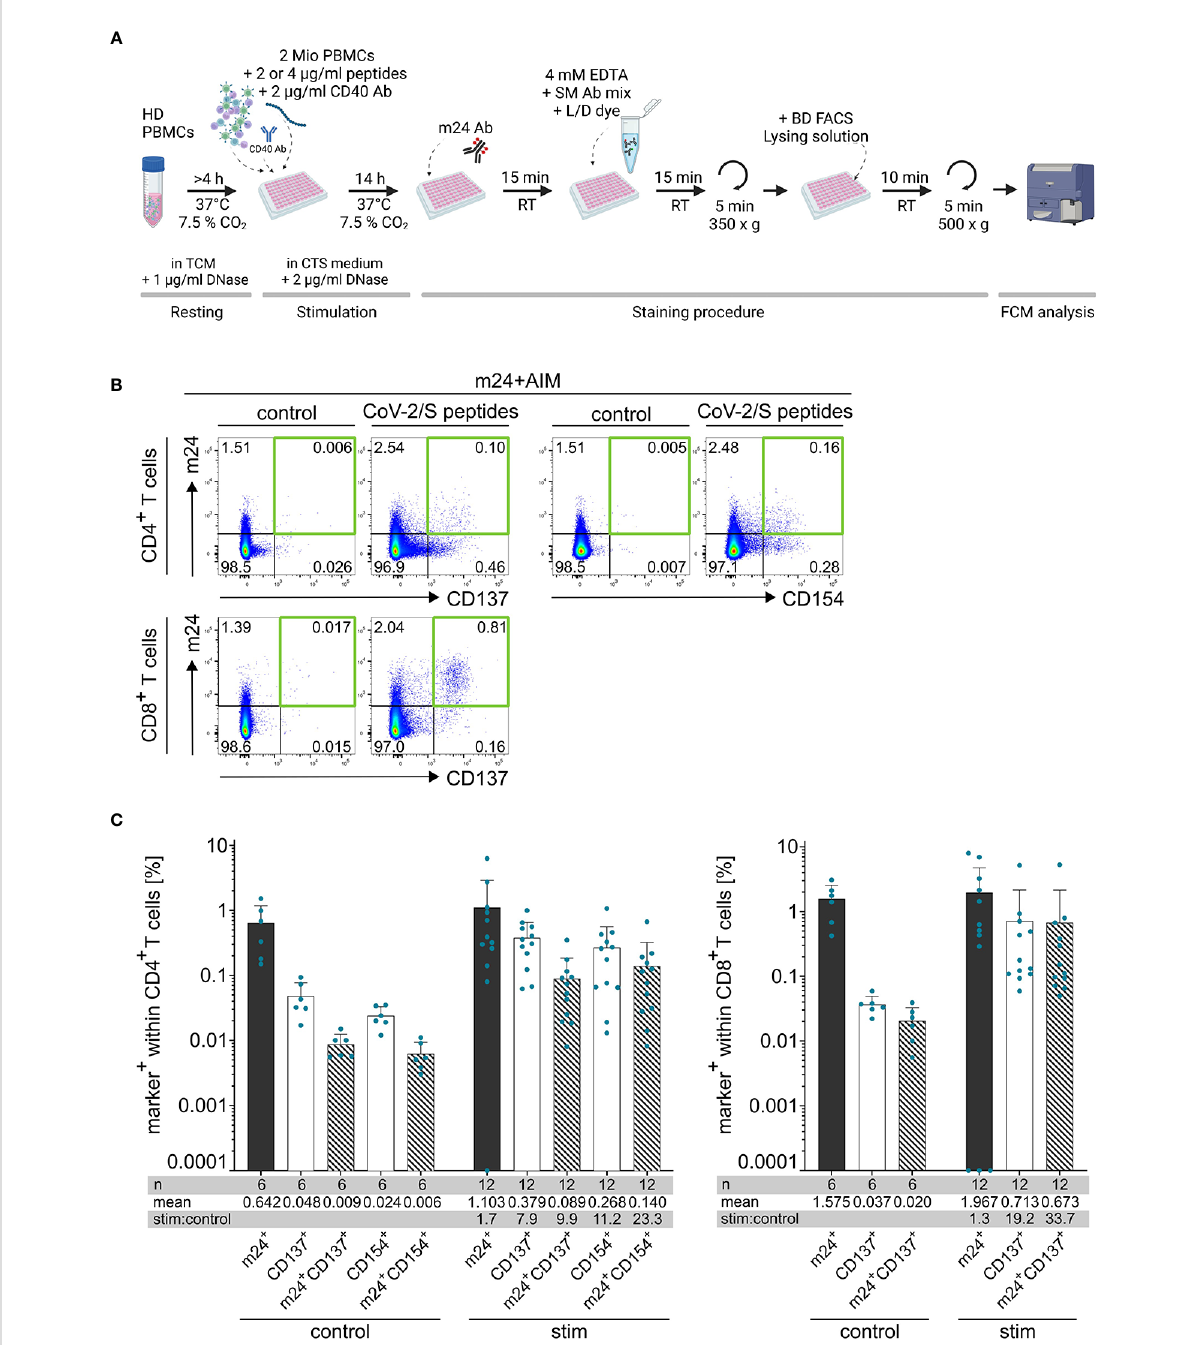
FIGURE 1 Co-staining of cell surface activated ß 2 -integrins with CD137 and CD154 (m24+AIM) allows identi fi cation of antigen-speci fi c T cells. (A) Scheme of the m24+AIM protocol (created with BioRender.com). PBMCs from healthy donors (HD) are stimulated with antigenic peptides or left unstimulated for 14 h in CTS medium + DNase in the presence of CD40 Ab. Activated ß 2 -integrins are then stained with m24 Ab, followed by incubation with EDTA, surface markers (SM) and live/dead dye (L/D) before fi xation and analysis by fl ow cytometry. (B) Exemplary dot plots of PBMCs from donor HD5 incubated with SARS-CoV-2/S overlapping peptides or unstimulated control. m24 Ab staining in combination with CD137 or CD154 expression on CD4 + T cells (top) or m24 Ab staining and CD137 expression on CD8 + T cells (bottom). Numbers represent frequencies within CD4 + or CD8 + T cells, the green squares mark the subsets of interest. (C) Mean + SD of the frequencies of cells expressing individual activation markers (unicolored bars) and combination of markers (striped bars) within CD4 + (left) and CD8 + (right) T cells. Number of donor/antigen combinations tested (n), mean and stimulated:control ratios (stim:control) are indicated. Frequencies of stimulated samples are background subtracted. Values that were 0 were set to